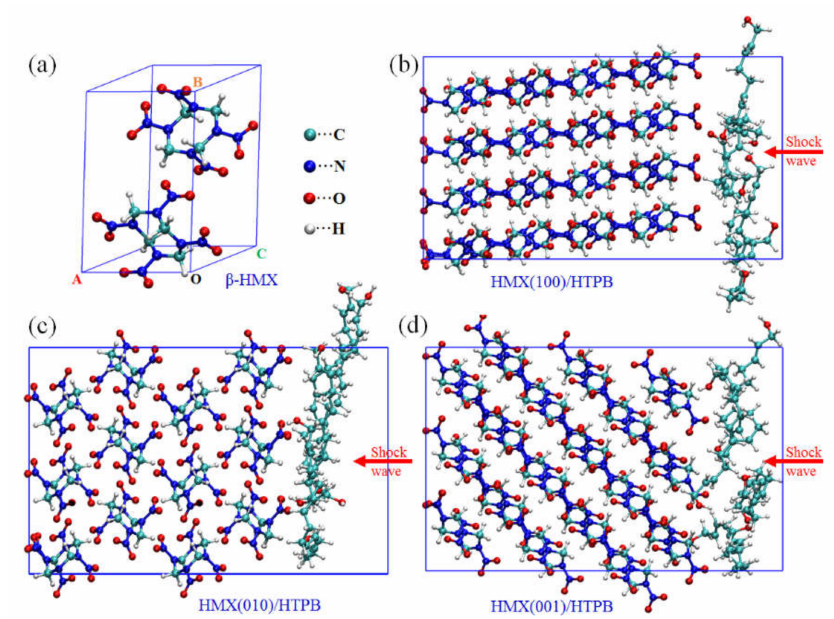
Figure 1. Initial models for HMX/HTPB compositions under shock loading: ( a ) β -HMX crystal, ( b ) HMX(100)/HTPB, ( c ) HMX(010)/HTPB, ( d )